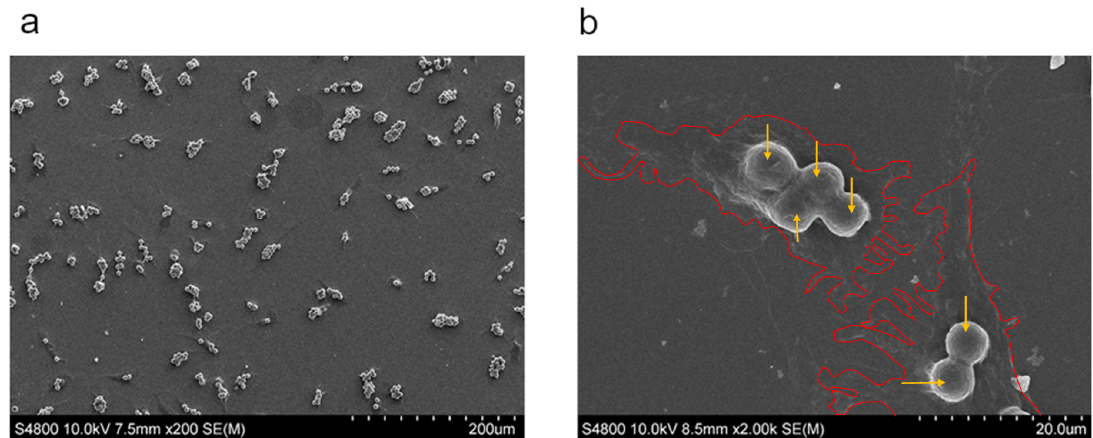
Figure 4. SEM images showing M0 macrophage after incubation with 5 NCM/cell. NCMs are colocalized with macrophages. ( a ) ×200; ( b ) ×2000. Edges of the cells (red line) and NCM (orange arrows) are shown.